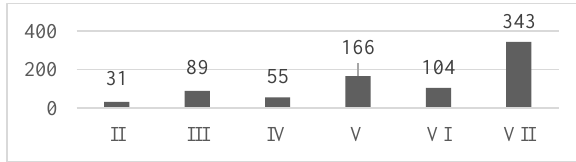
Figure 2 . Number of questions asked per task from the